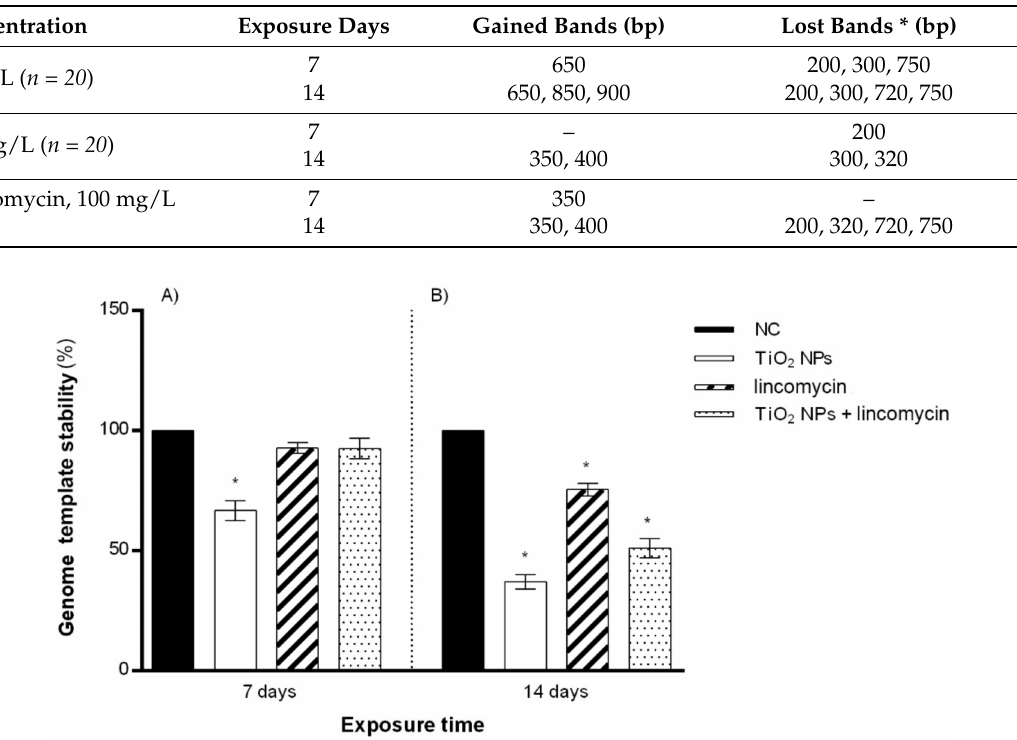
Table 1. Molecular sizes (bp) of bands that appeared or disappeared after amplification with primer 6 in zebrafish blood cells DNA exposed to TiO 2 NPs, lincomycin, or TiO 2 NPs–lincomycin in combina- tion. * Control bands are at 200, 240, 300, 320, 500, 550, 700, 720, 750, 800, 1000, and 1500 bp.